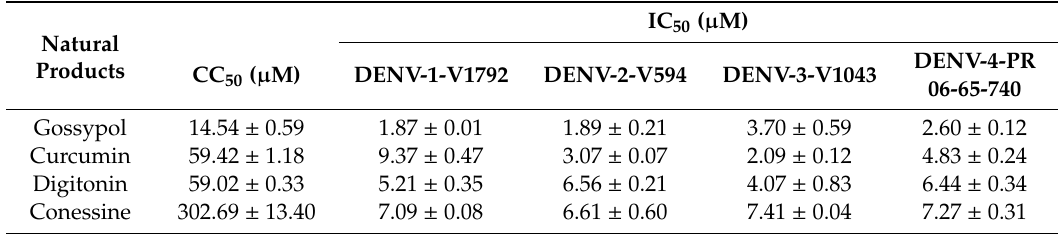
Table 7. Inhibitory activity of natural products against infections of DENV-1–4.